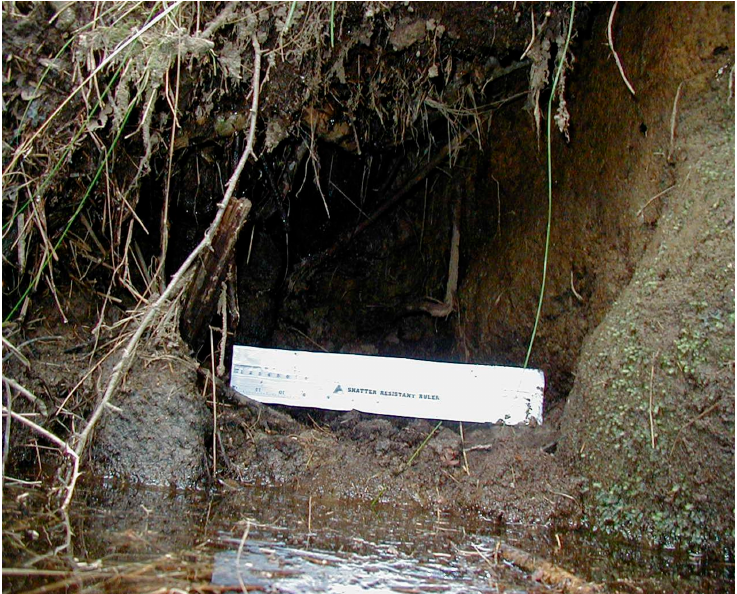
Figure A7. Cave at the end of the semi-circular channel. The depth of the cave is 0.5 m and it is located in the north bank of the stream. The debris in stream-bank trees downstream from the cave, indicating that the water rises to at least 1.1 m depth at times. The cave appeared the same in 2014 as it did in 2004.